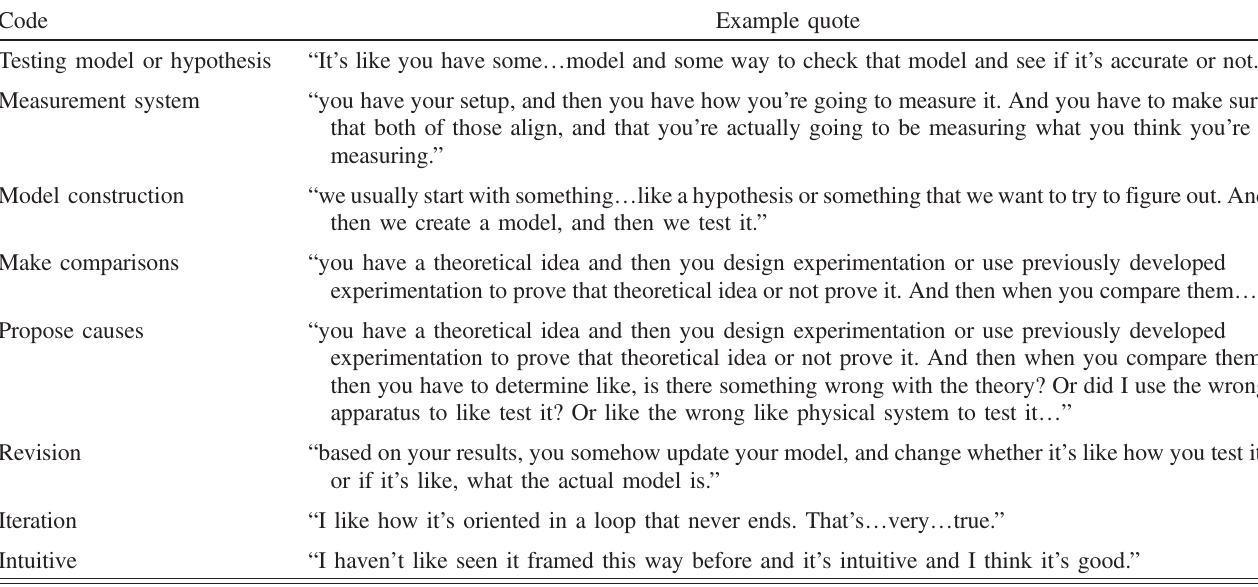
TABLE I. The eight codes that describe the key features of the modeling framework that students identified, along with an example student quote. These codes make up the first part of the codebook and correspond to part one of the interview.